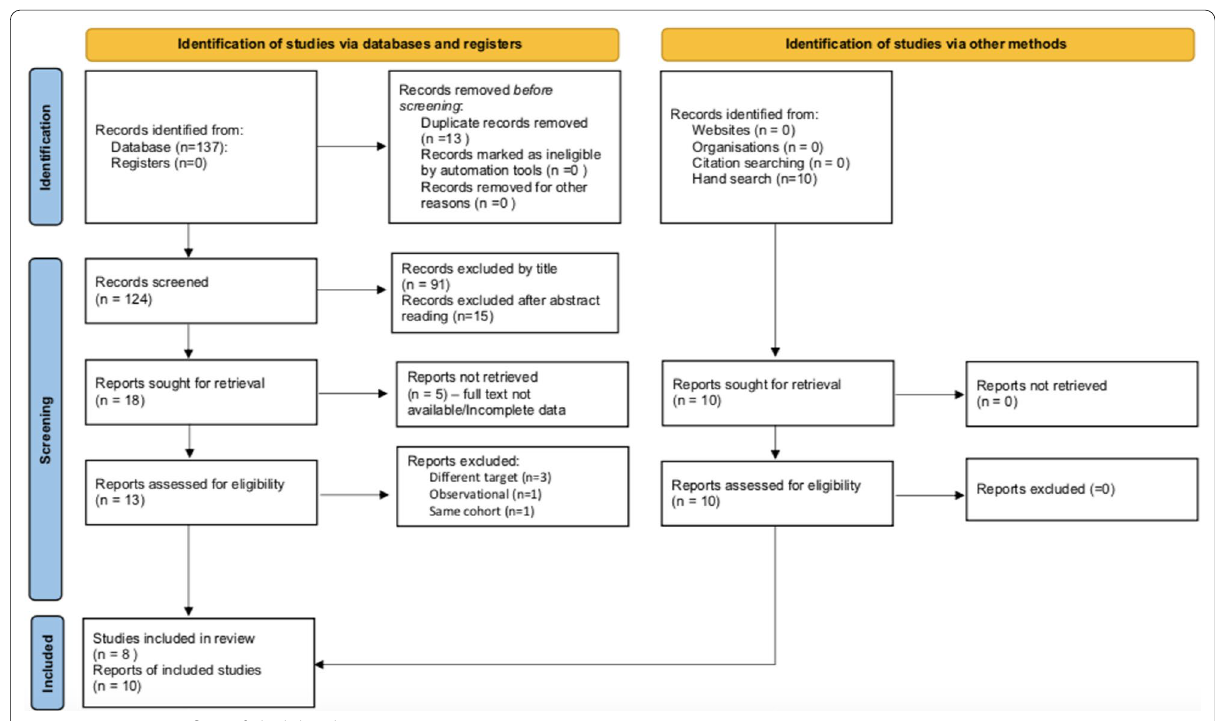
Fig. 1 PRISMA 2020 flow of eligibility diagram